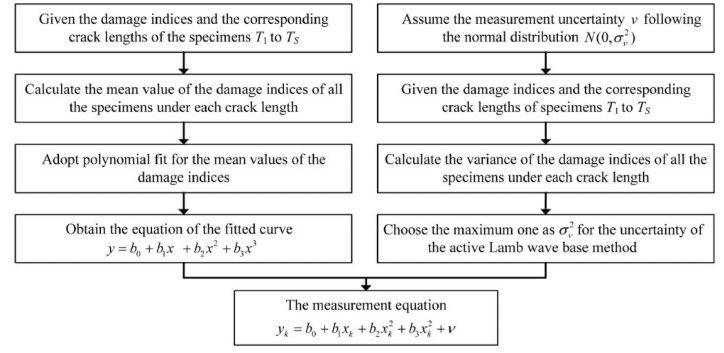
Figure 3. The process to establish the measurement equation by the data driven